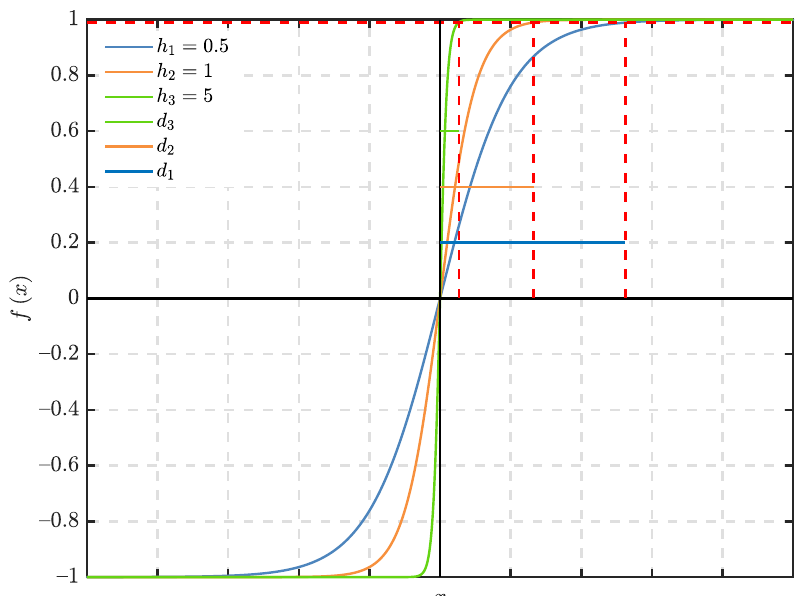
Figure 2. Hyperbolic tangent function for different h